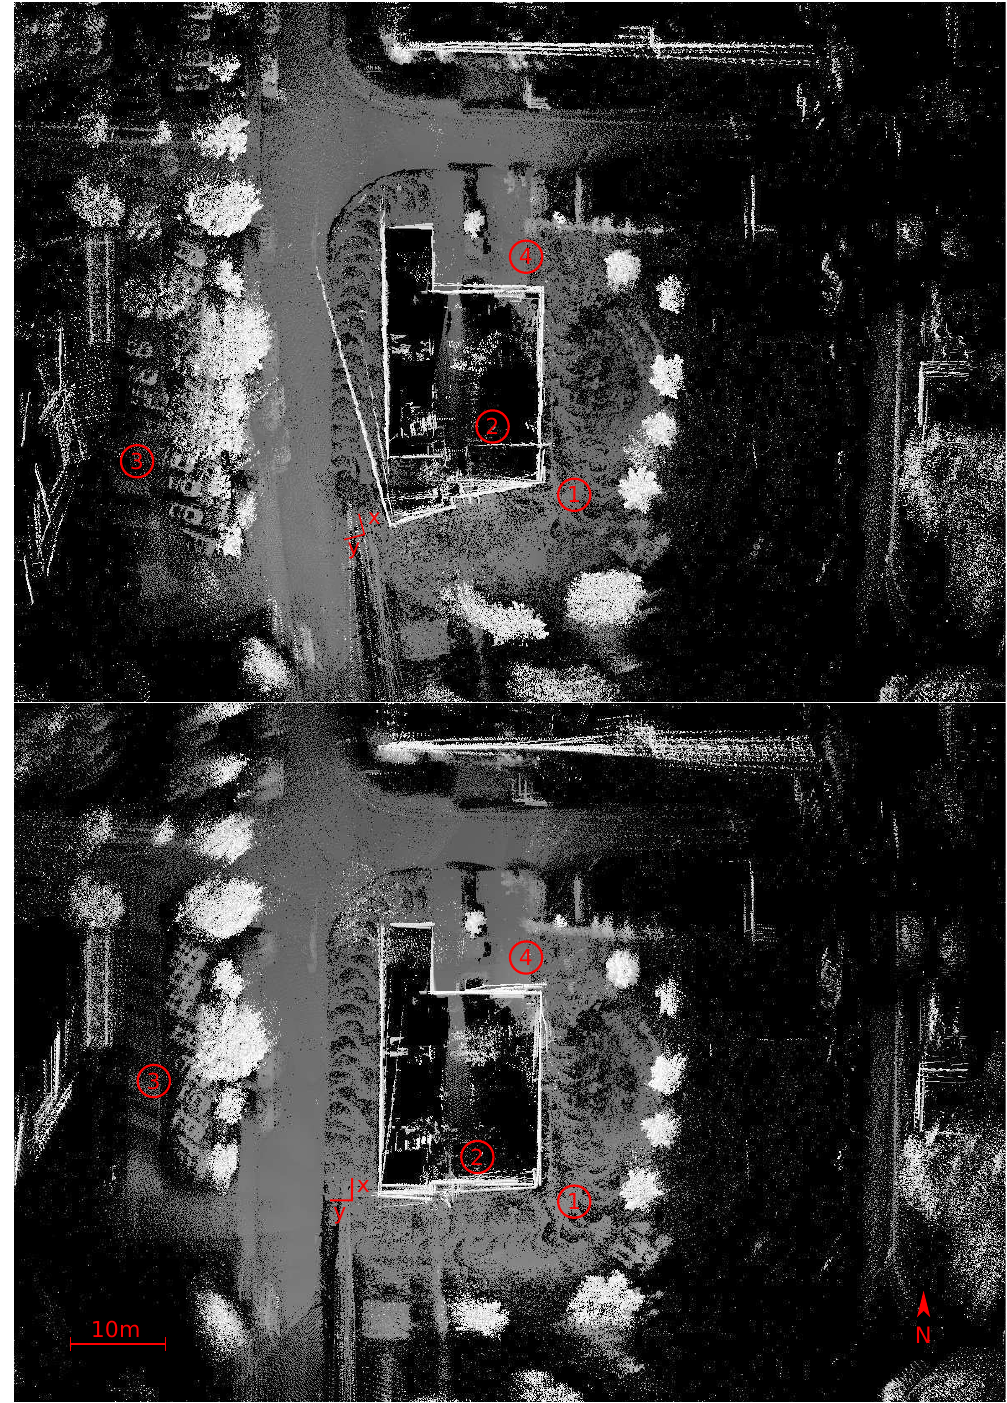
Figure 20. Bird’s eye view before (top) and after optimization (bottom). The rotation error at (1) decreased by semi-rigid optimization. The walls at (2) converged, but still do not match perfectly. The parking cars at (3) do not appear twice any more. At (4), inaccuracies increased due to distributing the initial transformation error during preregistration. The origin of the local coordinate system corresponds to the starting point of the